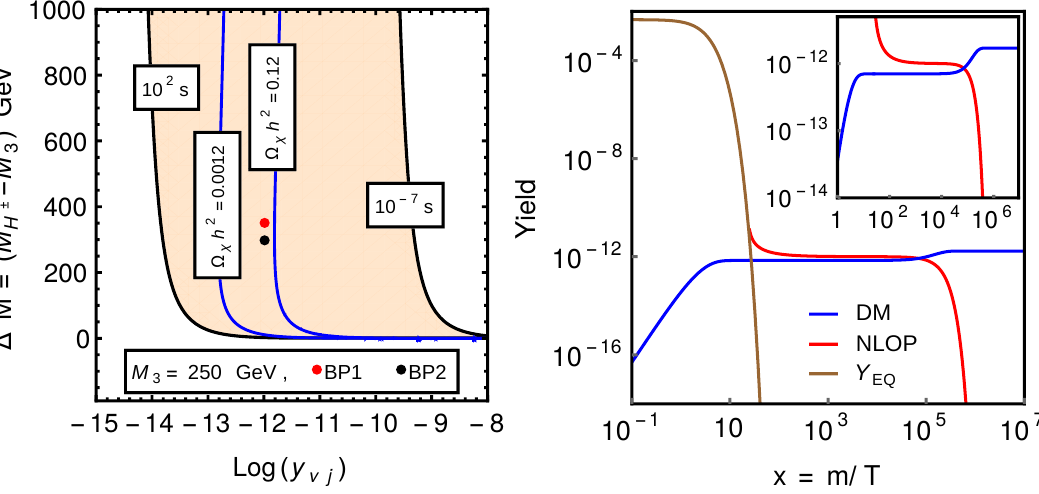
Figure 2 . Contours of lifetime of HSCP candidates (Black) and freeze-in relic density of DM candidate (cid:31) (Blue) as a function of mass di(cid:11)erence between NLOP and DM candidate and minuscule coupling y (cid:23)j for inert doublet model with right handed Majorana neutrino in the left hand side plot. Detector length restricts the lower limit of lifetime to be 10 (cid:0) 7 sec and the BBN constrains the lifetime to be less than 100 sec. Current data of CDM relic density further constrains the parameter space. The benchmark points we have used for the collider analysis are represented as the black and red points. The plot in the right depicts the yield of DM candidate (cid:31) in Blue and that of NLOP in red as a function of x = m , m being the mass of the NLOP. For this plot we have assumed T M = 500 GeV and M 3 = 250 GeV. The brown curve shows the equilibrium distribution of the H (cid:6) NLOP. The e(cid:11)ects after freeze-out of NLOP is magni(cid:12)ed in the inset. In the right panel of (cid:12)gure 2 we depict the evolution of the NLOP (red) as well as the DM (blue) as a function of temperature of the Universe. The plot has been generated considering M = 500 GeV, M = 250 GeV and y (cid:24) 10 (cid:0) 12 . The qualitative features 3 (cid:23)j H (cid:6) of the yield of NLOP and DM are same as in the earlier model. The plot in the left panel of (cid:12)gure 2 shows the allowed parameter region as a function of (cid:1) M and y which (cid:23)j is consistent with correct CDM relic density. Also in the left panel of (cid:12)gure 2 we have pointed the benchmark points for the collider